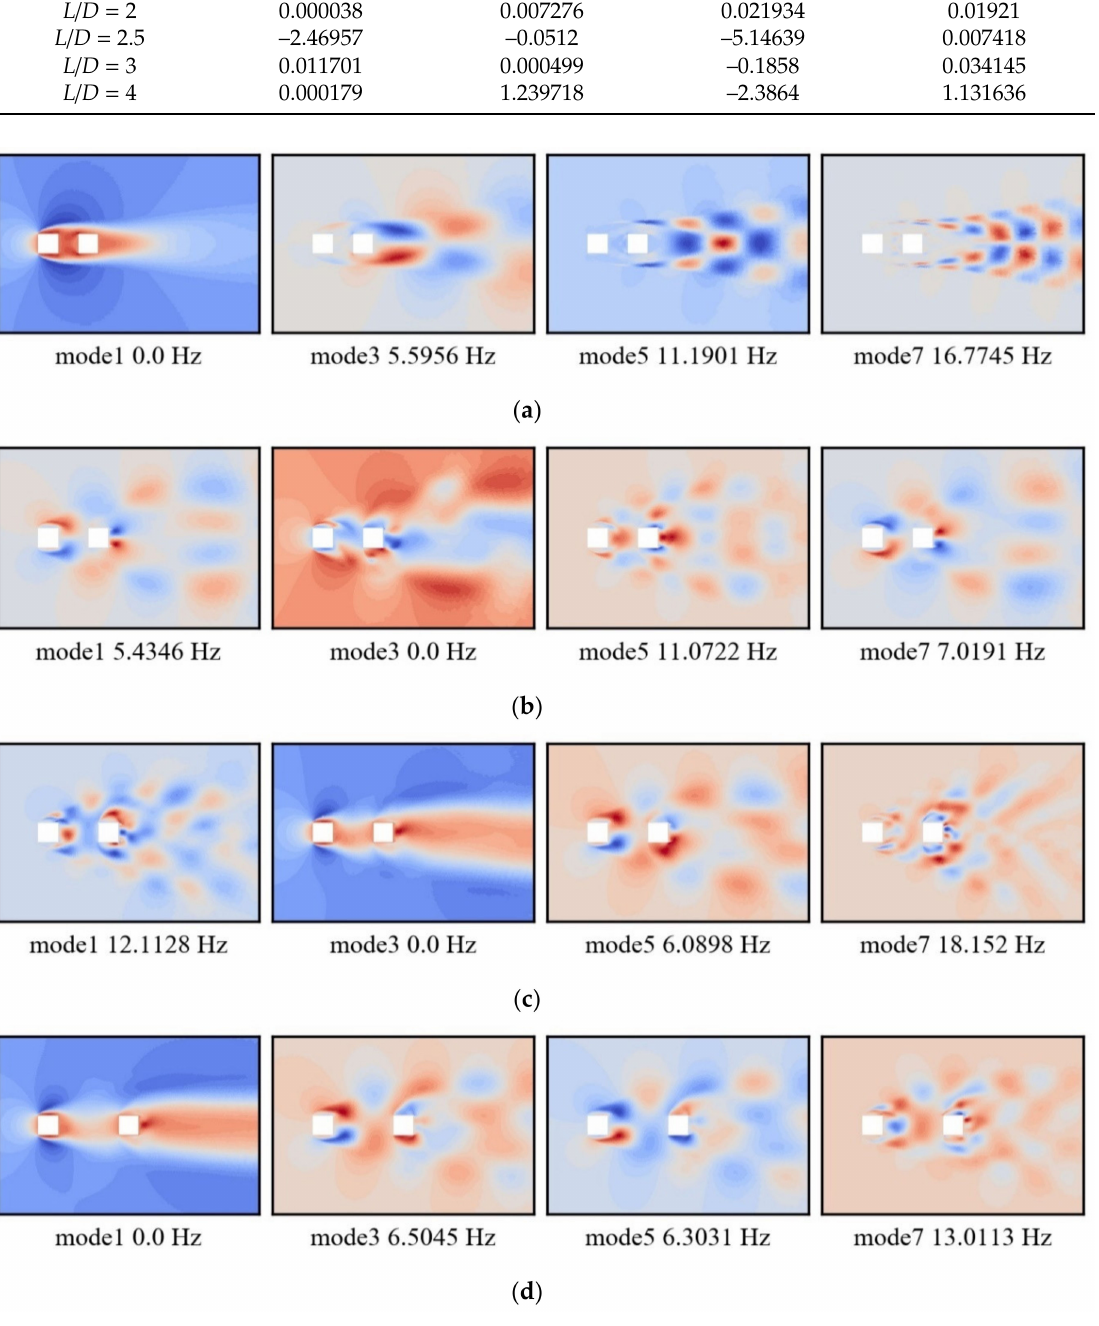
Figure 12. The DMD modes of the flow field around two square cylinders at di ff erent spacing ratios: ( a ) L / D = 2; ( b ) L / D = 2.5; ( c ) L / D = 3; ( d ) L / D =